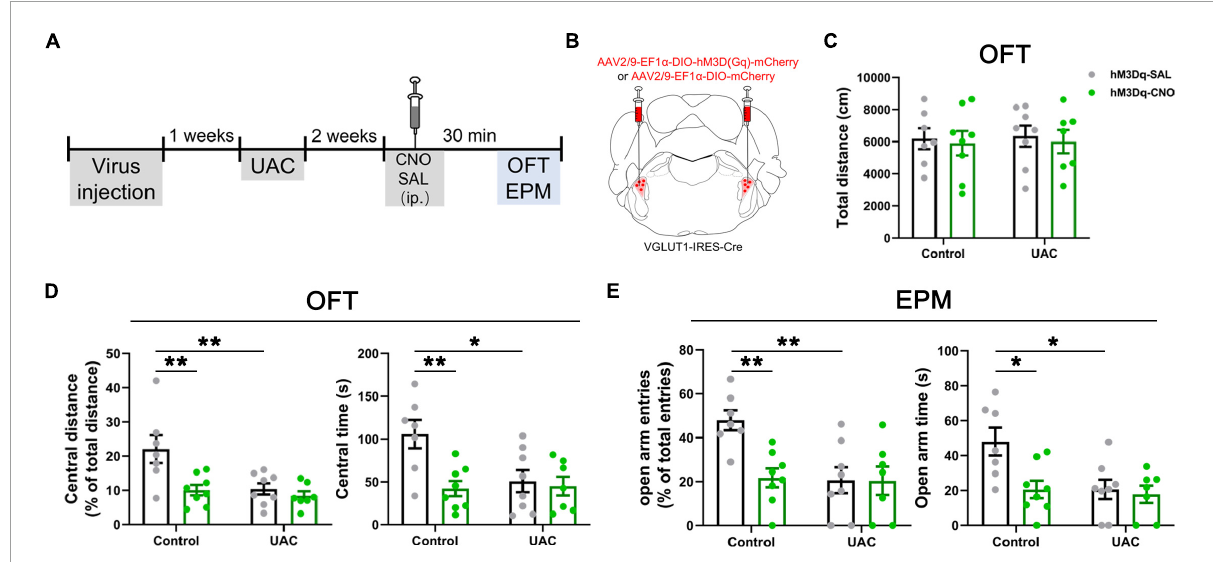
FIGURE3 Chemogenetic activation of VGLUT1-ir neurons in the Vpdm induced anxiety-like behaviors in control mice but did not aggravate UAC-induced anxiety comorbidity. (A) Timeline of chemogenetic activation of Vpdm VGLUT1 neurons to investigate anxiety-like behaviors. (B) Schematic showing the virus injection into the Vpdm of VGLUT1-IRES-Cre mice. (C) The total distance traveled in the OFT was identical under chemogenetic manipulation. (D) In the OFT, the activation of Vpdm VGLUT1 neurons decreased the percentage of central distance and the time spent in the central area in the control mice but did not exacerbate UAC-induced anxiety comorbidity. (E) In the EPM, the activation of Vpdm VGLUT1 neurons decreased the percentage of open arm entries and the time spent in the open arms in the control mice but did not exacerbate UAC-induced anxiety comorbidity. Data are expressed as the mean ± SEM. Tukey’s post hoc was performed between the groups: hM3Dq-SAL-treated control mice ( n = 7) versus hM3Dq-SAL-treated UAC mice ( n = 8) and hM3Dq-SAL-treated control mice versus hM3Dq-CNO-treated control mice ( n = 8). * P < 0.05, ** P <